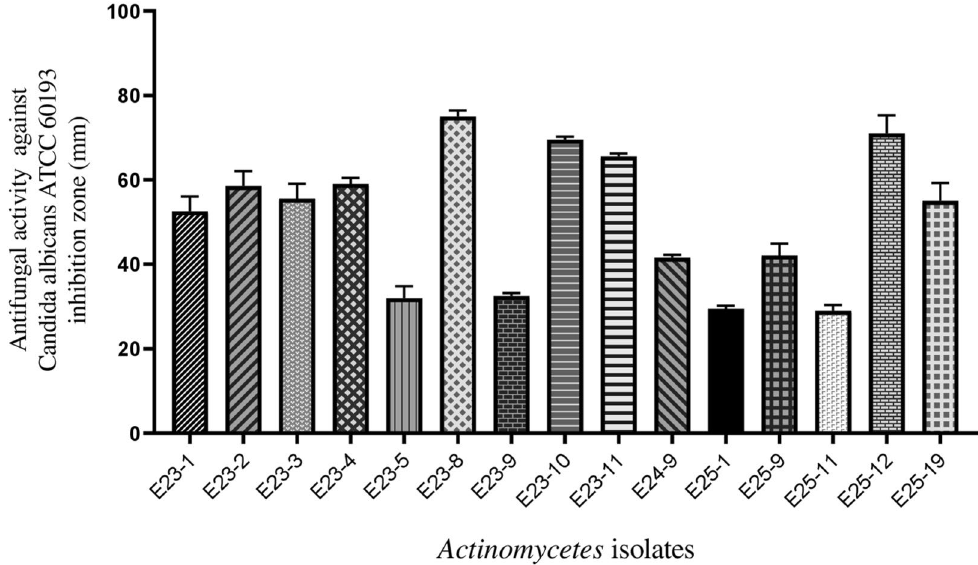
Figure 3. Primary screening (antifungal activity) by the double layer method on ISP2 medium against Candida albicans ATCC 60,193.